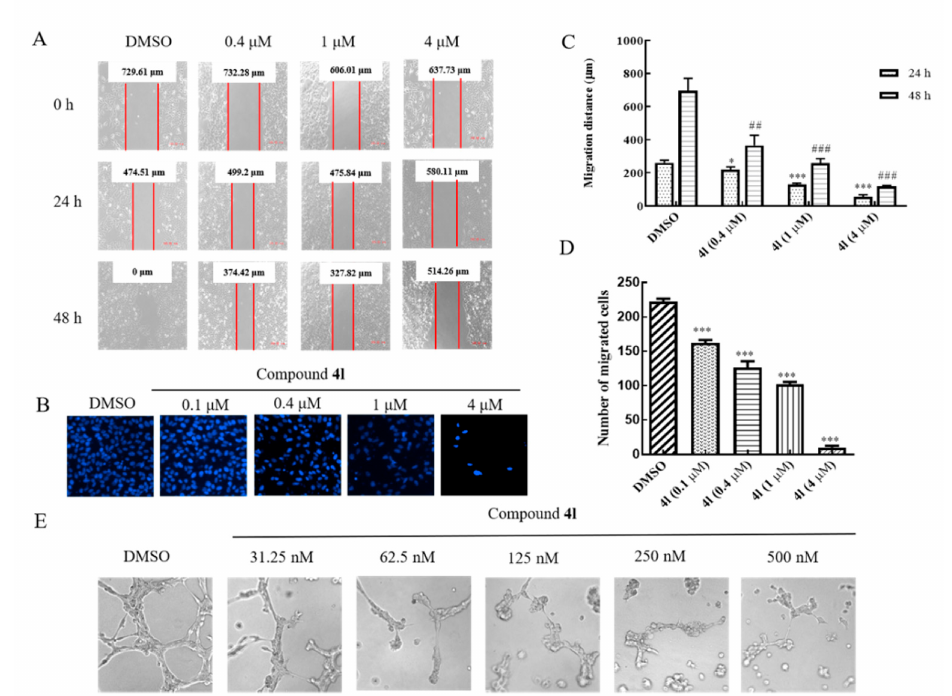
Figure 4. Effect of compound 4l on HepG2 cells migration and on HUVECs tube formation. ( A ) Using 0, 0.4, 1, 4 µ M contration for wound healing assay. ( B ) Using 0, 0.1, 0.4, 1 and 4 µ M concentration for transwell assay, taking 100-fold photographs under an inverted microscope. ( C ) Transverse migration distance. ( D ) Number of migrated cells at different concentrations. ( E ) Detection of the ability of compound 4l to tube formation on matrix glue. Compound concentrations ranging from 31.25 to 500 nM inhibited tube formation of HUVEC cells. (* p < 0.5 versus DMSO, *** p < 0.001 versus DMSO, ## p < 0.01 versus DMSO, ### p < 0.001 versus DMSO, Compound 4l